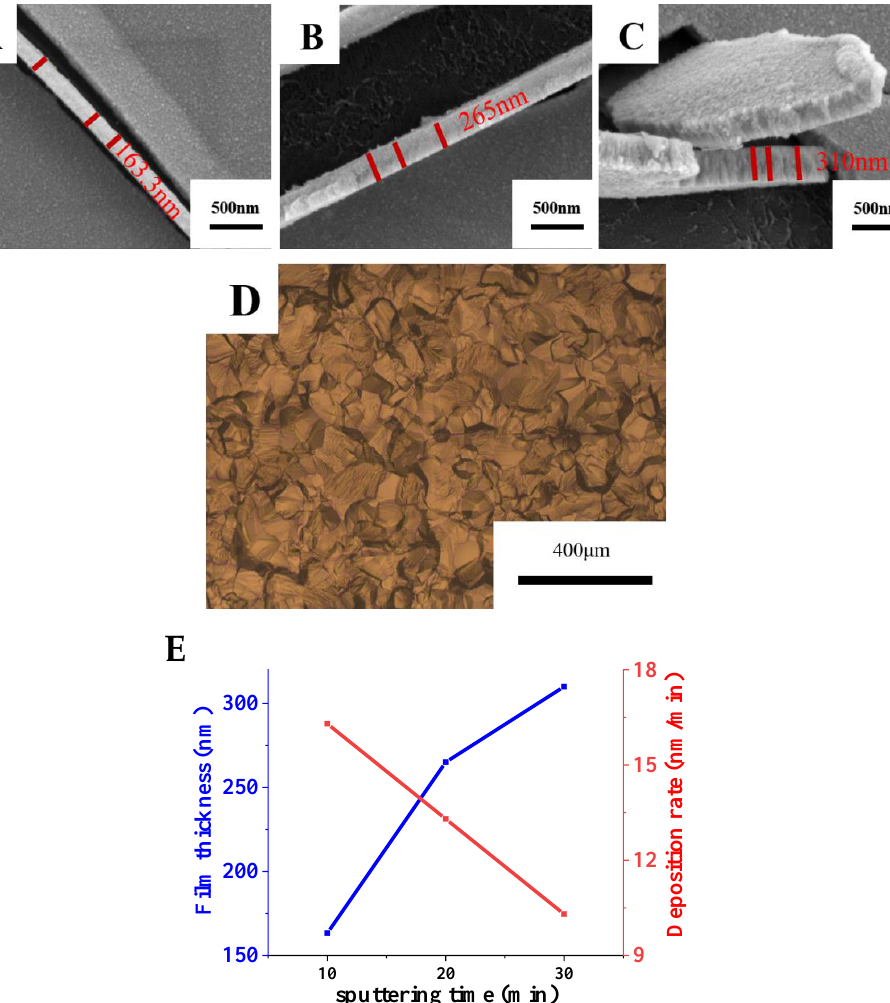
Figure 6. Sputtering morphology of target C and cross-sectional morphologies and deposition rates of Ti films prepared by target C with different sputtering times. ( A ) Sputtering time: 10 min; ( B ) Sputtering time: 20 min; ( C ) Sputtering time: 30 min; ( D ) Sputtering morphology of target C; ( E ) Variation of the film thickness and deposition rate with sputtering time.